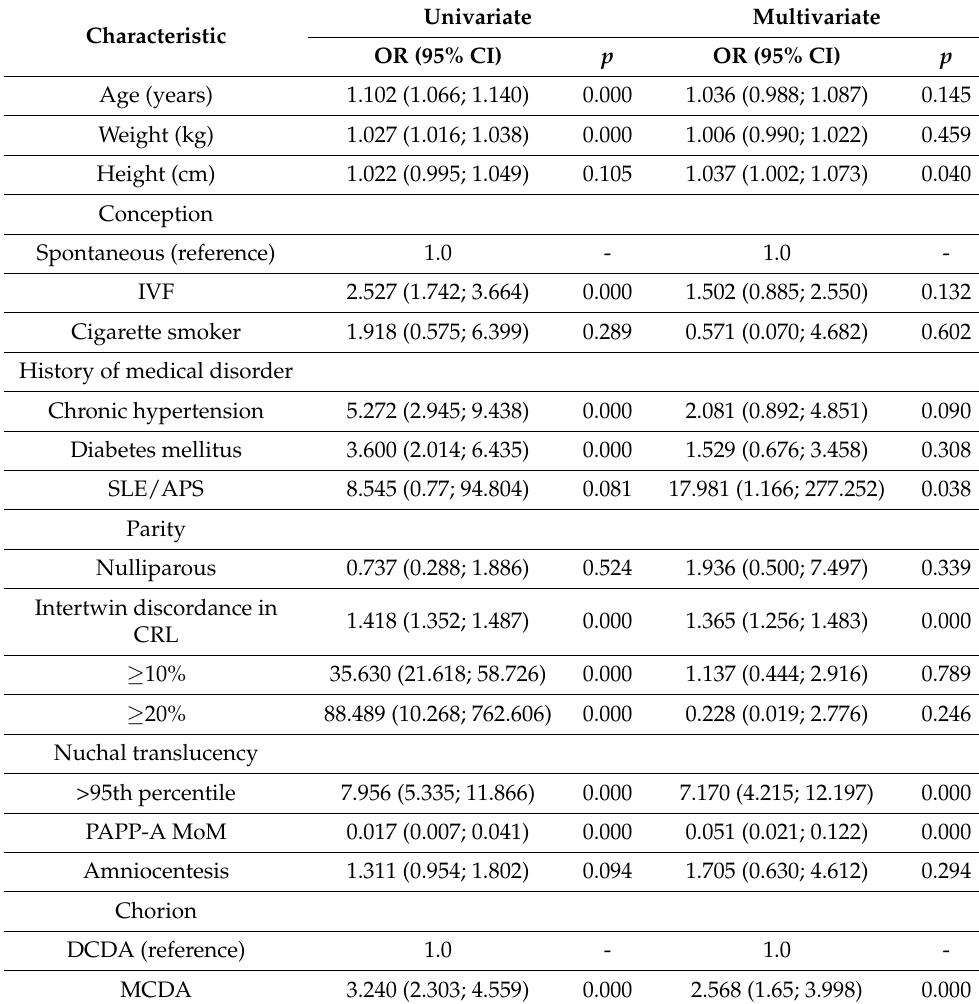
Table 3. Univariable and multivariable regression analysis to assess contribution from maternal and pregnancy characteristics and independent contribution of amniocentesis in prediction of miscarriage. Univariate Characteristic